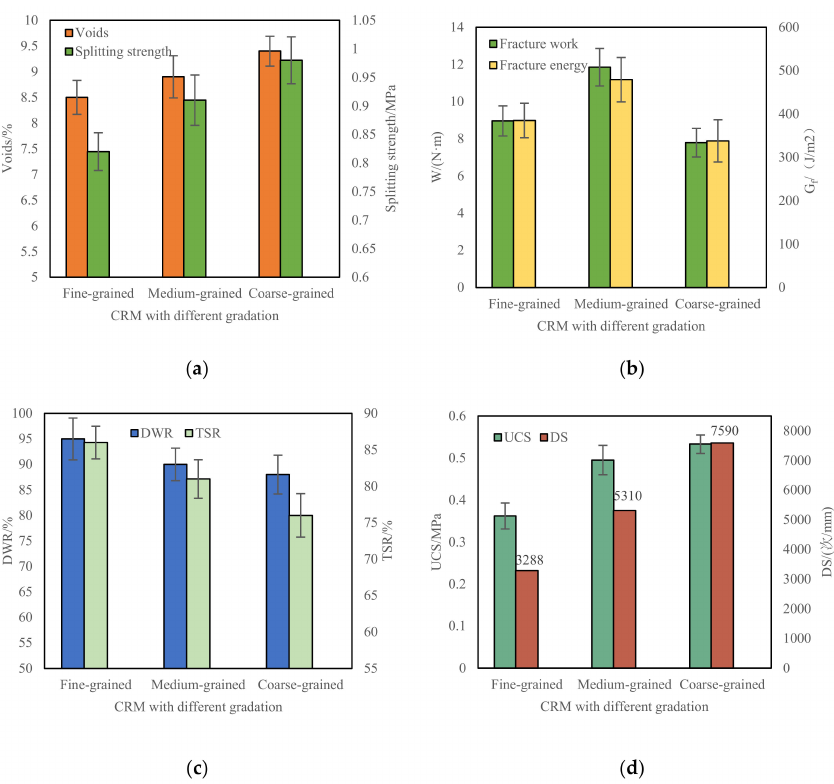
Materials 2022 , 15 , x FOR PEER REVIEW 12 of 16 Figure 6. Performance and voids test results of CRM under different gradation. ( a ) Voids and R T ; ( b ) W and G f ; ( c ) DWR and TSR; ( d ) UCS and DS.